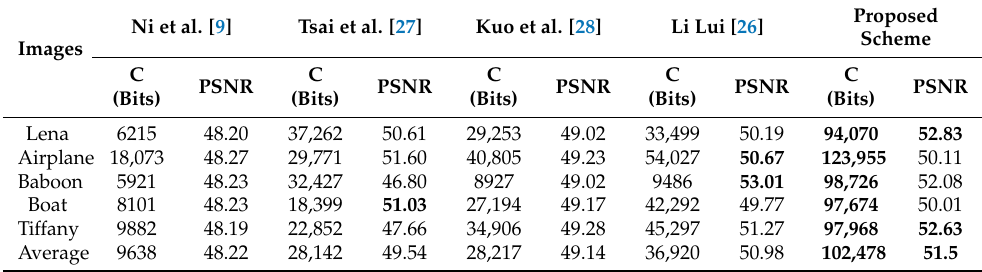
Table 7. RDH schemes comparison with proposed scheme. Bold shows the best results achieved by a